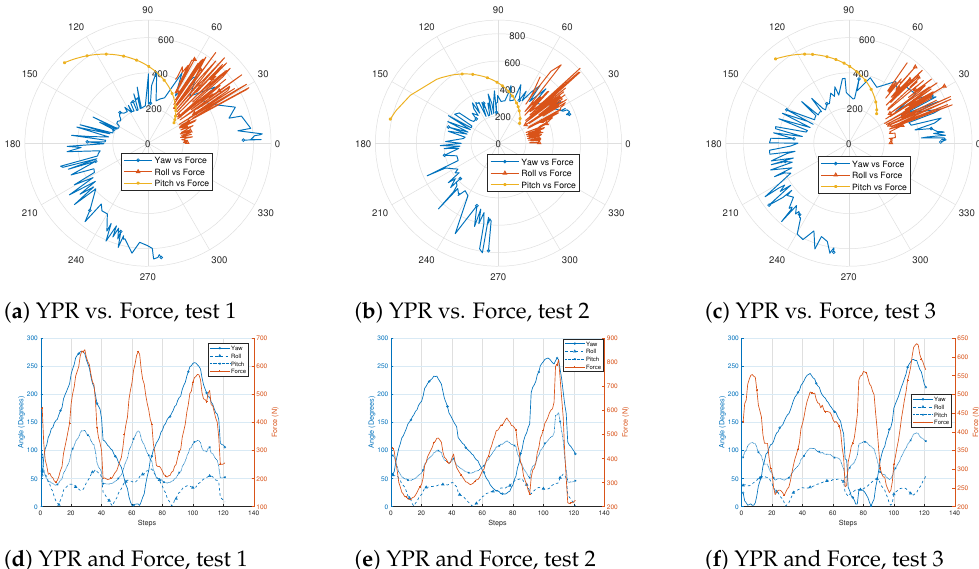
Figure 16. Tether force simulation for three test cases: ( a – c ) polar plots of the YRP vs. force; the sweep represents the angles (0 ◦ to 360 ◦ ) and the magnitude represents the tether force, ( d – f ) time-series plots of the YRP and the tether force under the steady wind conditions.